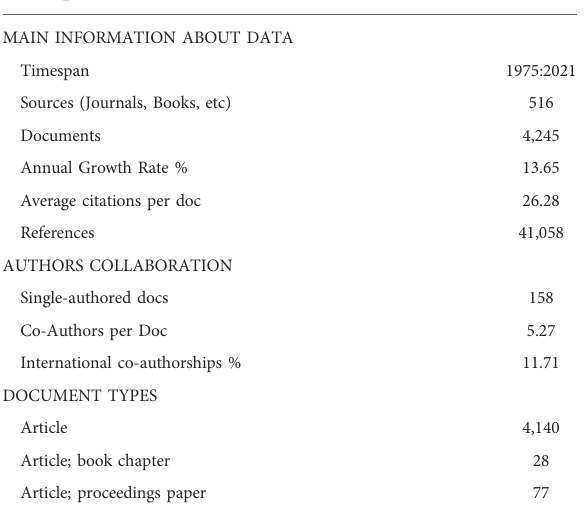
TABLE 1 Main information of included articles for bibliometric